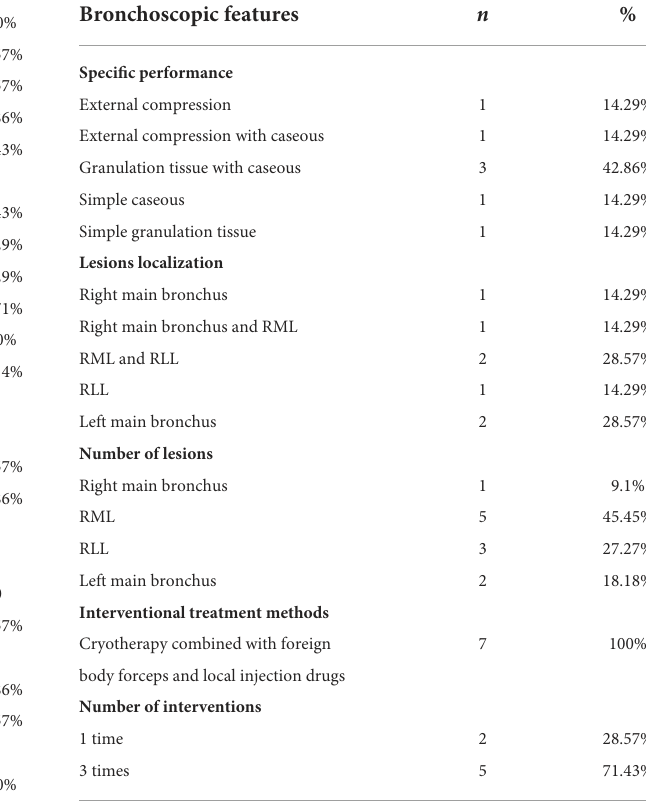
TABLE 3 Bronchoscopic lesion